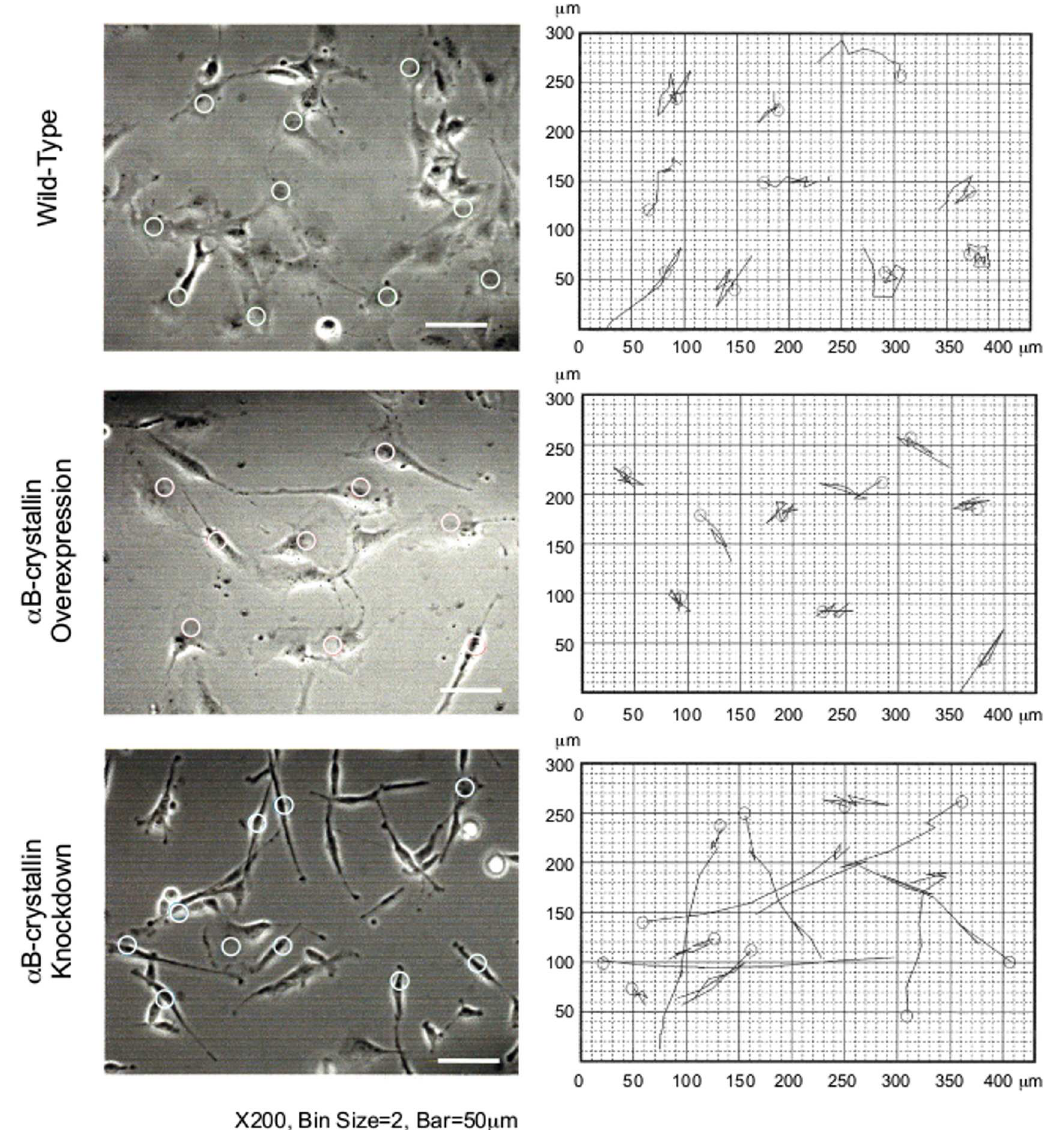
Fig 9. Mode of migration of wild-type, α B-crystallin overexpressing and knockdown cells. Bar is 50 μ m. Time- lapse images were recordedfor 2 h at 10 min intervalsand traces of the migrationwere drawn on the right hand graph. Circles on the left panel indicatethe center of the cells at the beginningof the image